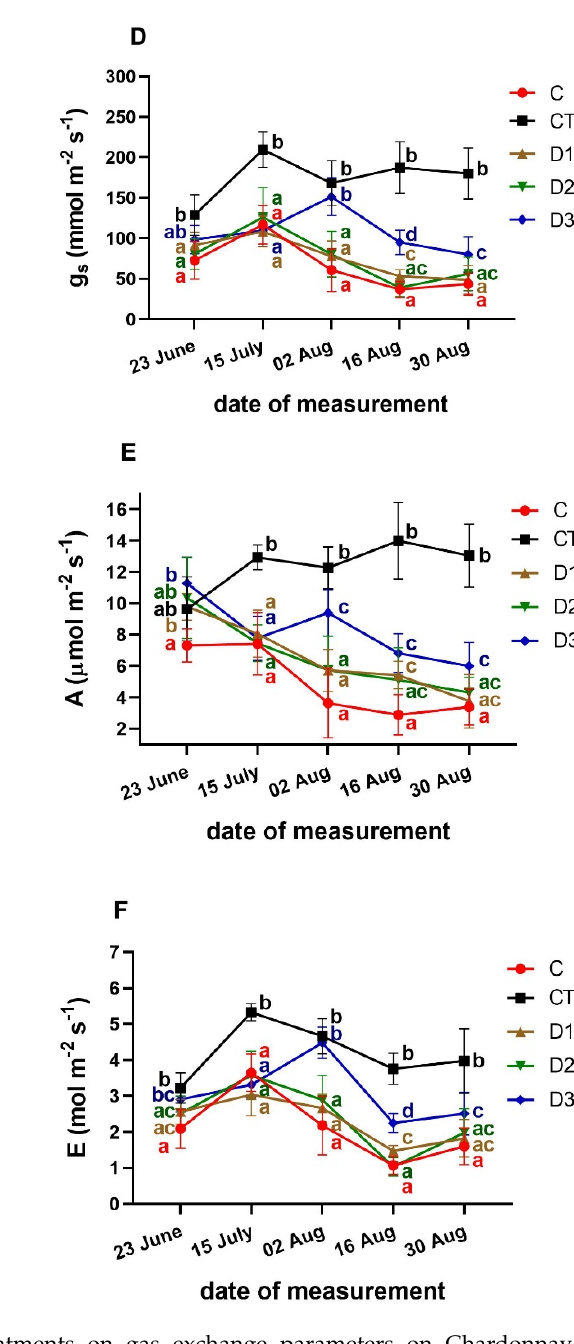
Figure 4. ( A − F ) Effects of treatments on gas exchange parameters on Chardonnay ( A − C ) and Kékfrankos ( D − F ) varieties in 2014: g s (mmol m − 2 s − 1 ) − stomatal conductance ( A , D ), A (µmol CO 2 m − 2 s − 1 ) − assimilation rate ( B , E ), and E (mol H 2 O m − 2 s − 1 ) − transpiration rate ( C , F ) during the growing seasons. Each symbol represents the mean value ± standard deviation (SD). Significance groups of each measurement date are marked with letters ( p < 0.05). The color of the letters corresponds to the color of the treatments.